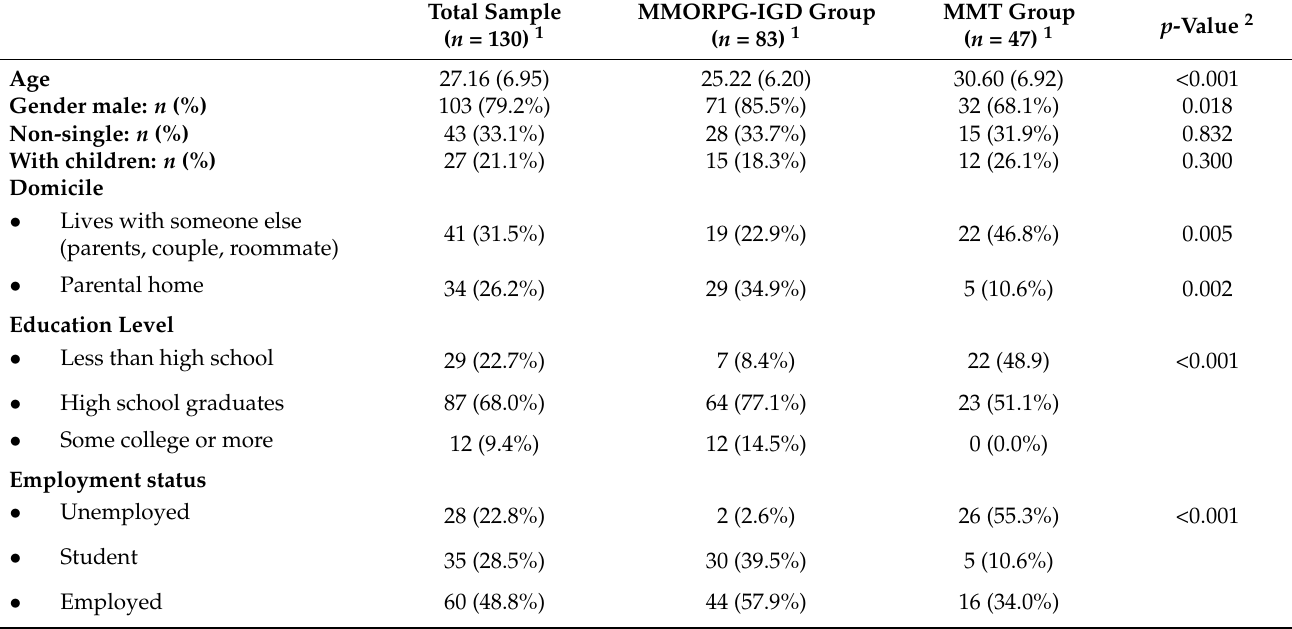
Table 1. Participant data.